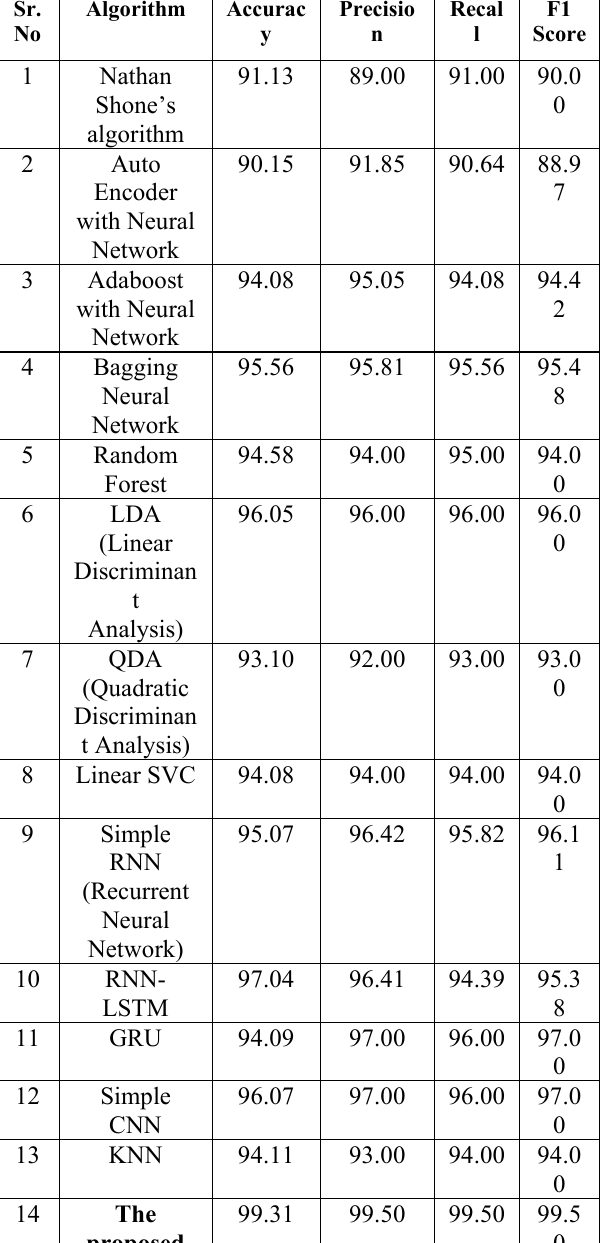
TABLE. II. Random Forest Metrics